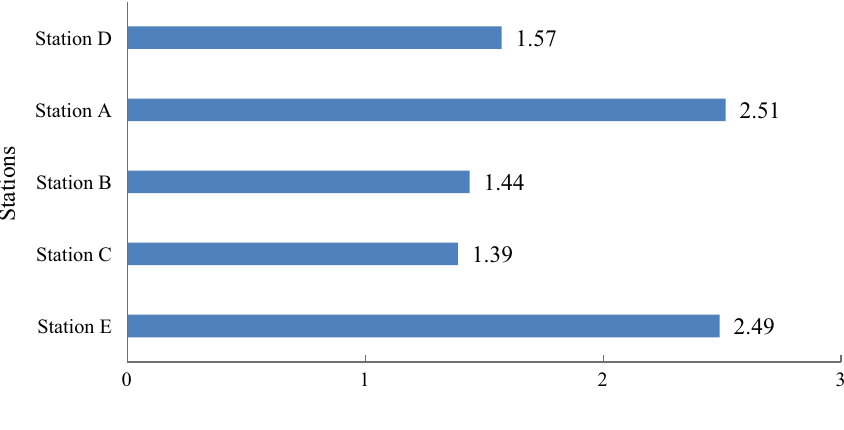
Fig. 11 Scatter plot all study areas: violin plot for all study areas: a study area D, b study area A, c study area B, d study area C, and e study area E Fig. 12 Results of relative error (RE) of hybrid BA-ANN for all five study